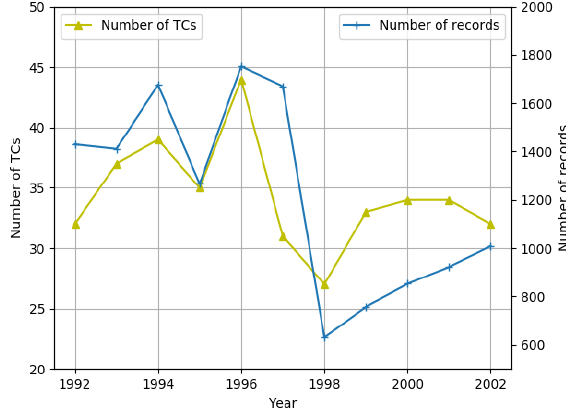
Figure 6. Comparison results of NWP and AE-GRU models from 1992 to 2002.